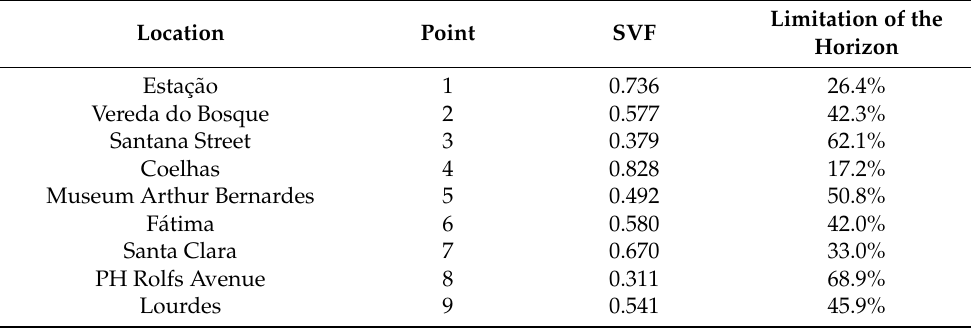
Limitation of the